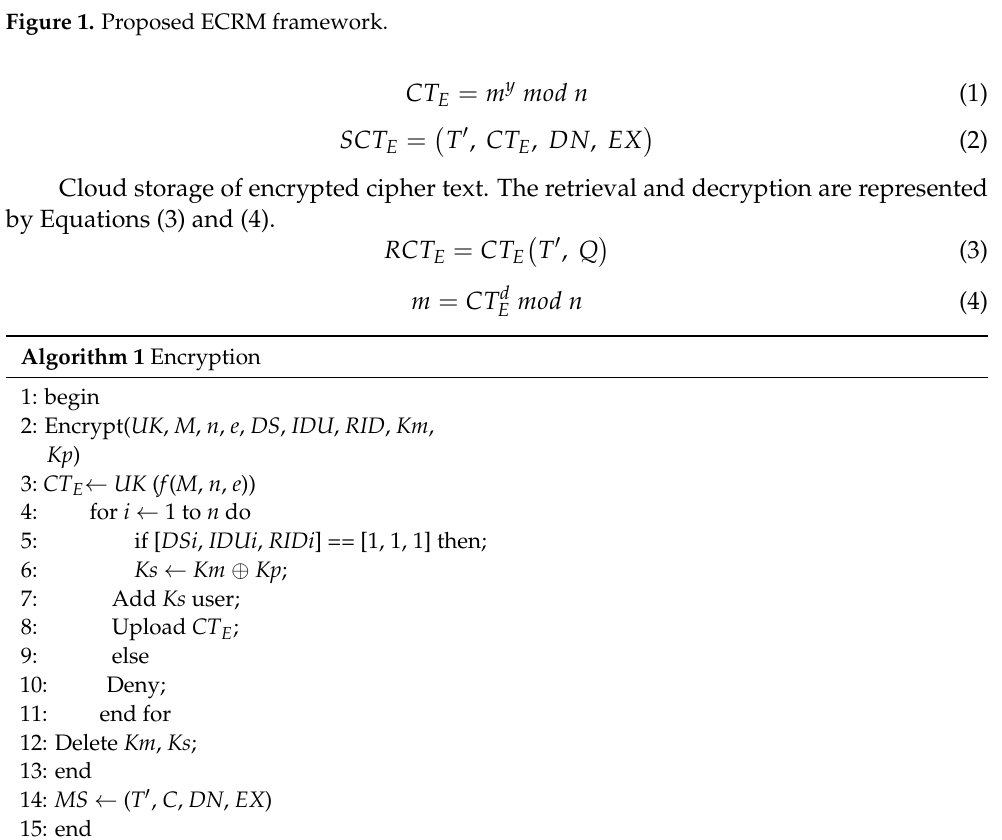
Figure 1. Proposed ECRM framework.